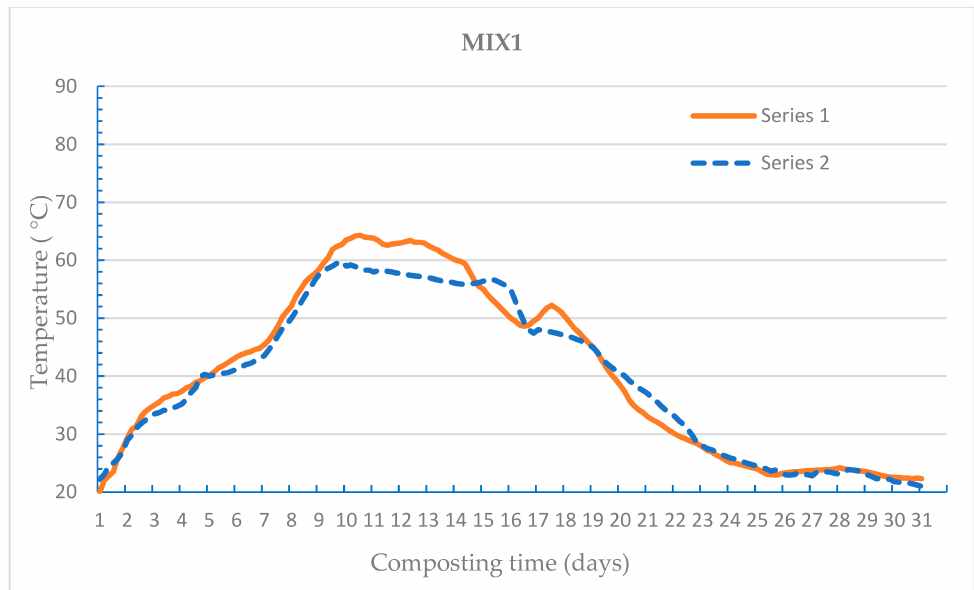
Figure 2. Changes in temperature during the composting of MIX1.